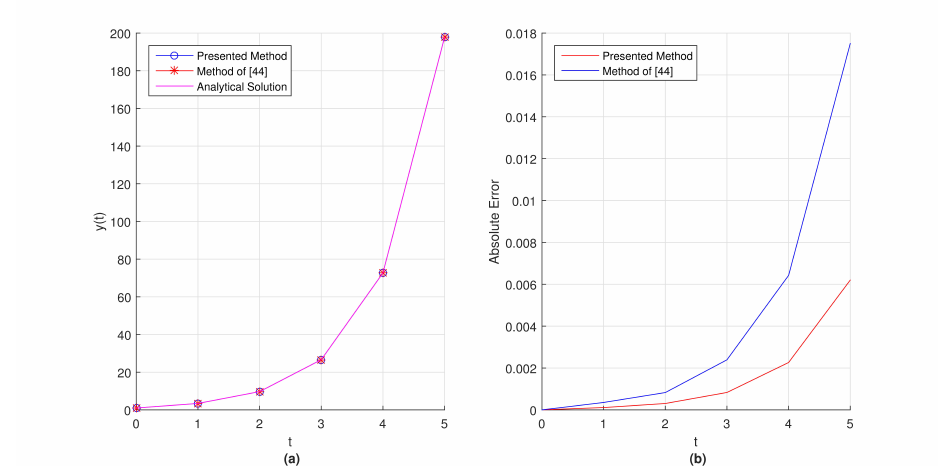
Figure 17. ( a ) The comparison of analytical solution and numerical solutions obtained by the proposed method and the method of [63] with m = 20. ( b ) The behaviour of the absolute errors between the exact solution and numerical solutions obtained by our method and the method given in [63] with m =